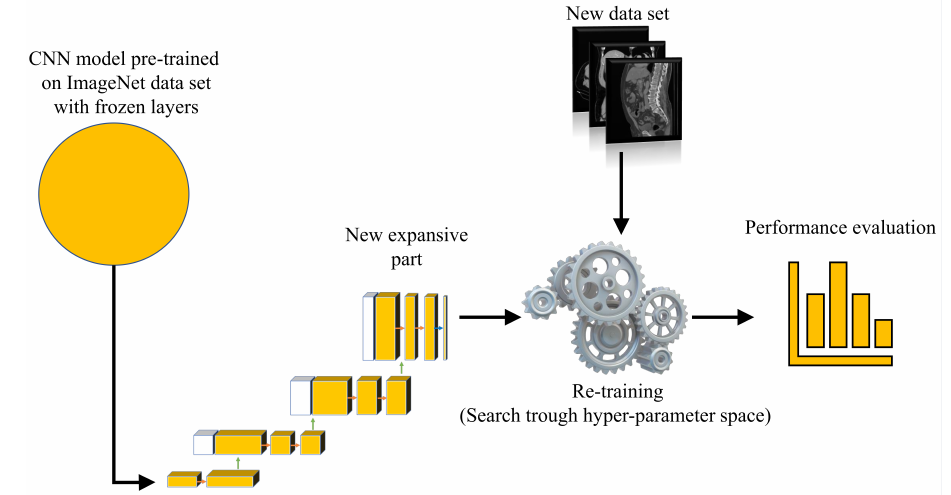
Figure 6. A block scheme of the proposed